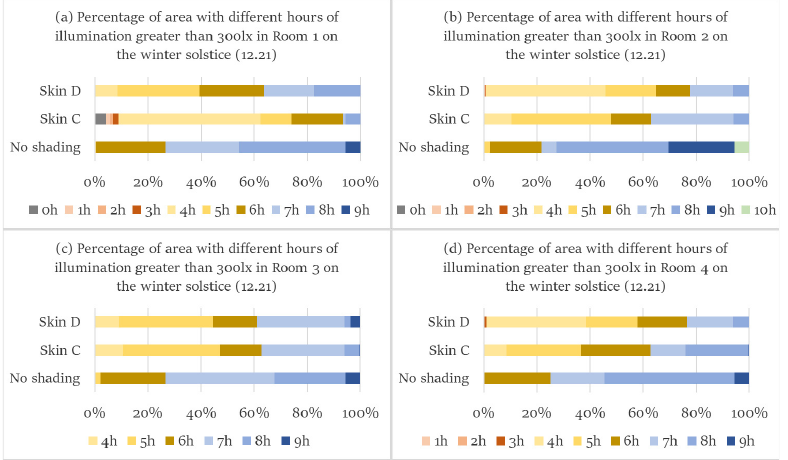
Figure 16. Percentage of the area with different hours of illumination greater than 300l× in ( a ) Room 1, ( b ) Room 2, ( c ) Room 3, and ( d ) Room 4 on the winter solstice (12.21) (self-developed).